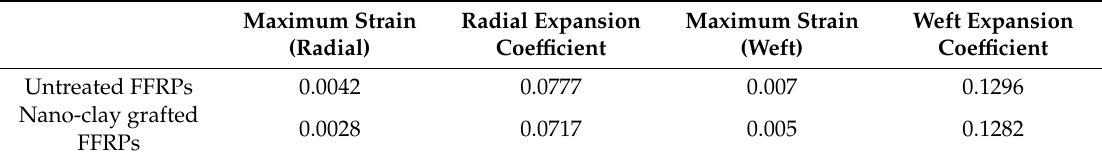
Table 4. Linear moisture expansion coe ffi cient of